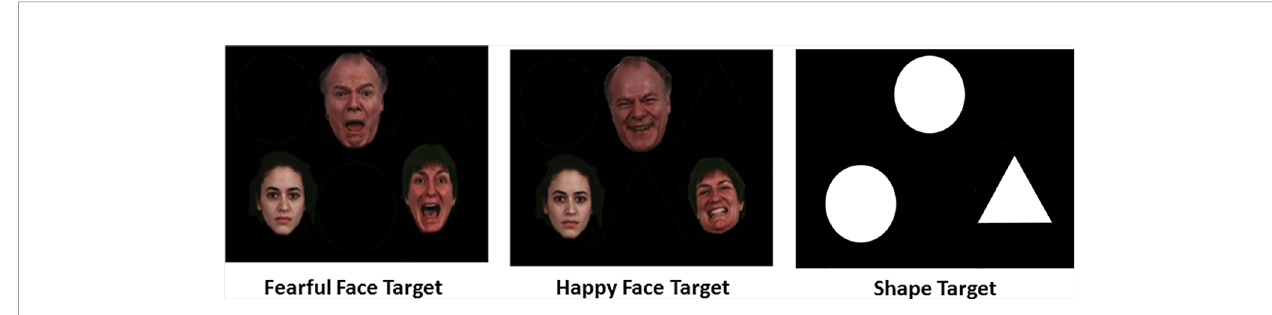
FIGURE 1 | Schematic of Emotional Face Matching Task conditions